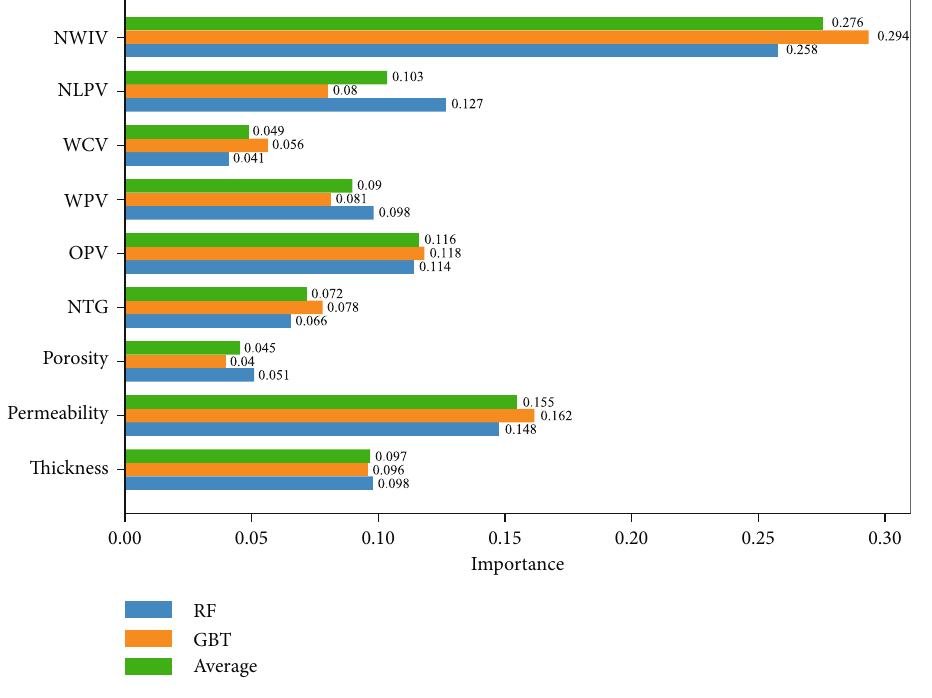
Figure 8: Importance of impact factor.